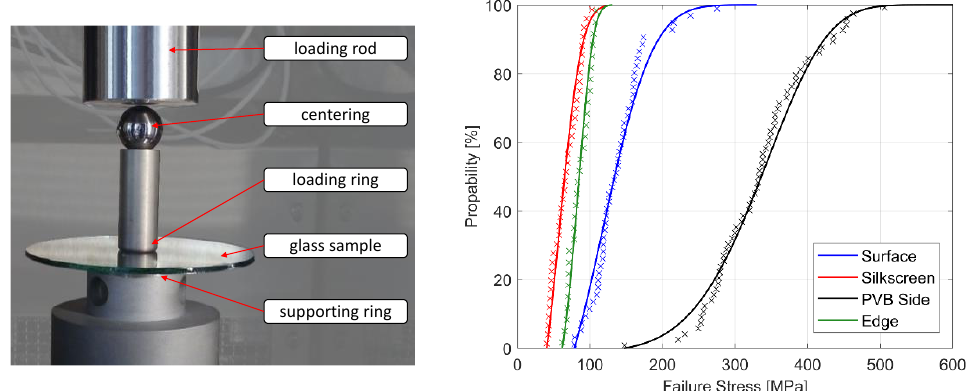
Figure 2. Test setup for the ring-on-ring tests (left) and distribution functions for the different areas (right), cf. [11].